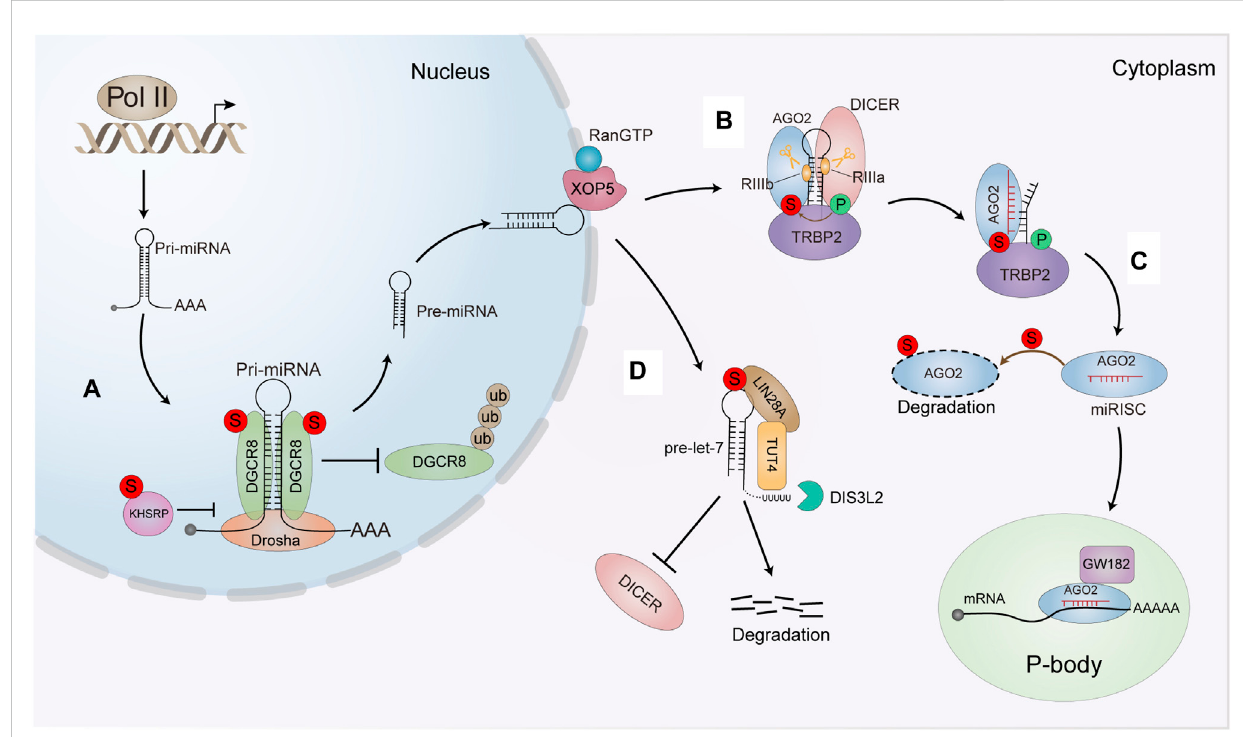
FIGURE 4 The effect of SUMO modi fi cation on the miRNA pathway. (A) OGCR8 SUMOyfation increases its protein stability by preventing the degradation via the ubiquitin proteasome pathway. The SUMOylation also enhances its af fi nity with pri-miRNA thus positively promoting the pri-miRNA direct recognition and repression of the targeted mRNA. SUMOylated KHSRP inhioits interaction with Dro-sha/DGCR8 and pri-miRNAs complex, sequentially downregulatlngasubsetofmiRNASbiogenesis. (B) SUMOylationofTARBP2 controls theef fi ciency ofRNA-inducedgenesilencingbyincreasingits interactionwithAGO2andprecursormiRNAs/siRNAs (C) SUMOytationenhancesAGO2turnoverandantagonizesitsstability. (D) SUMOylatedofLIN28 A (cid:129) increasesthebindingaf fi nityofLIN28 Aandpre-let-7.Therebyleadingtothedegradationofpre let-7andreducingmaturelet-7biogenesis.Theintense interaction between LIN28 A and pre-let-7 can ef fi ciently recruit TUT4 to urictylate pre-let-7 and block the processing of